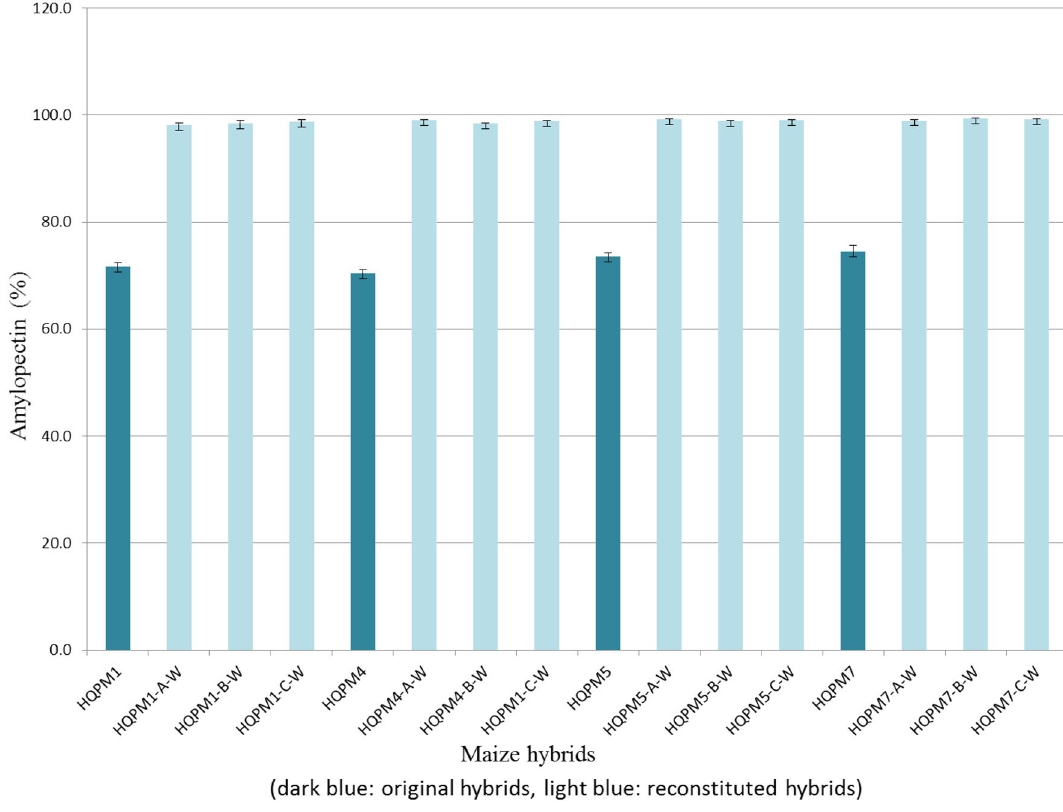
Figure 5. Amylopectin content in original- and reconstituted waxy-hybrids.